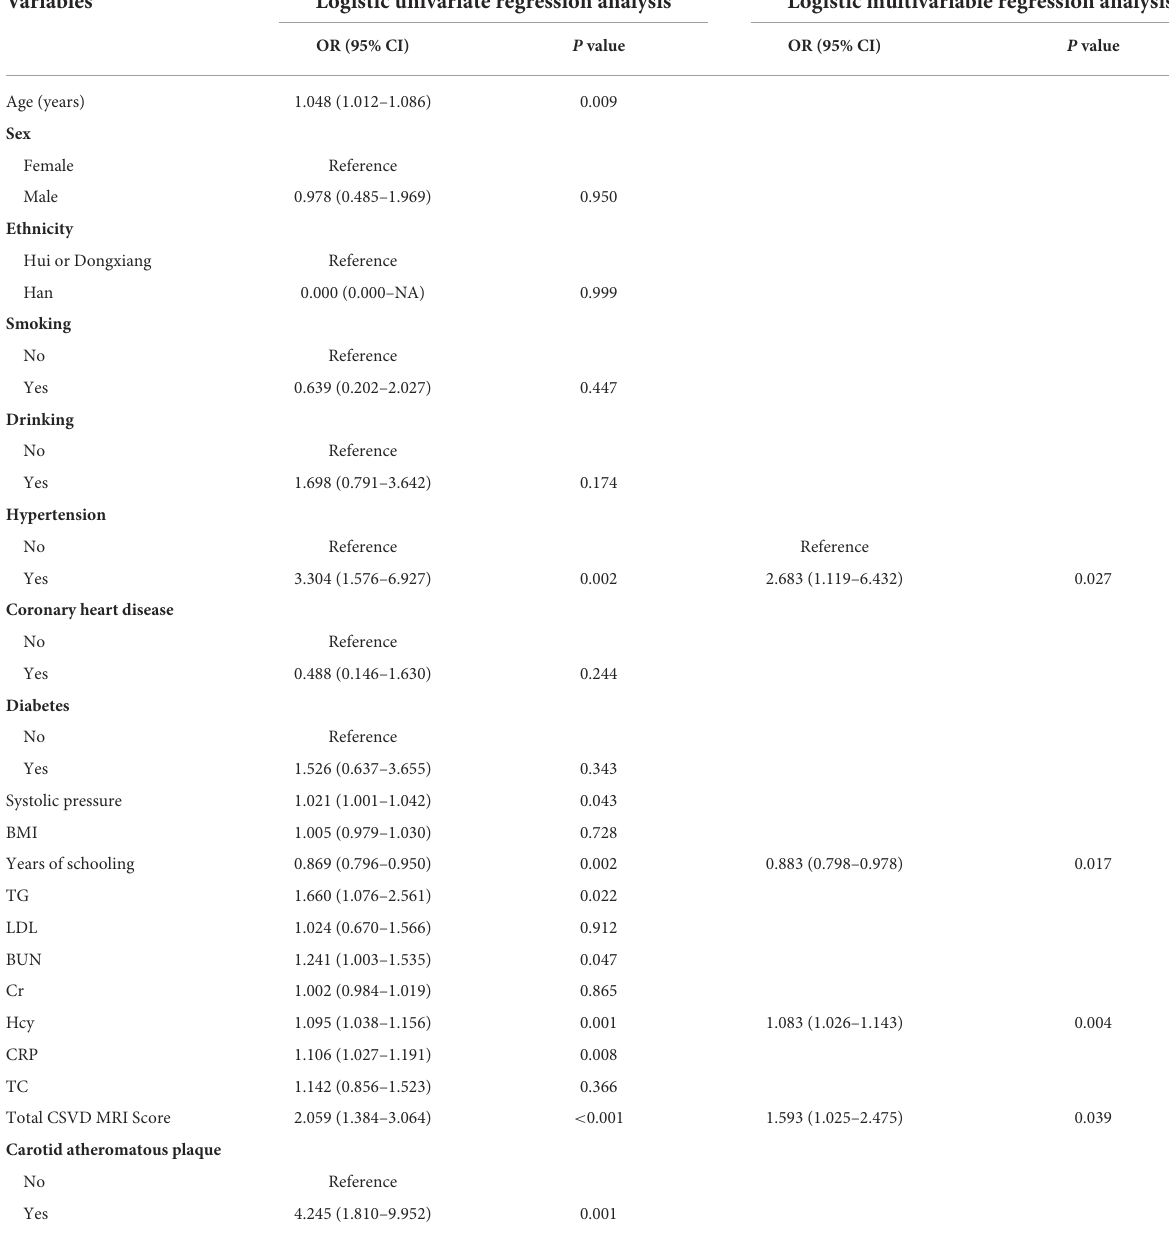
TABLE 3 Logistic univariate and multivariable regression analysis of cognitive impairment in patients with CSVD. Variables Logistic univariate regression